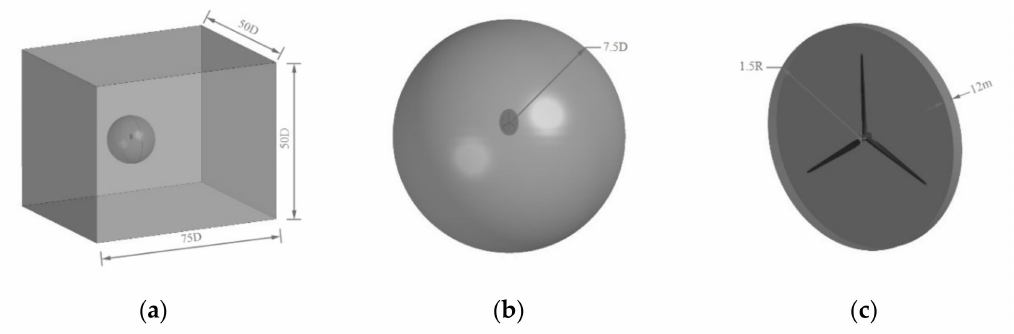
Figure 2. Computational zones: ( a ) far-field; ( b ) yaw zone; ( c ) rotational